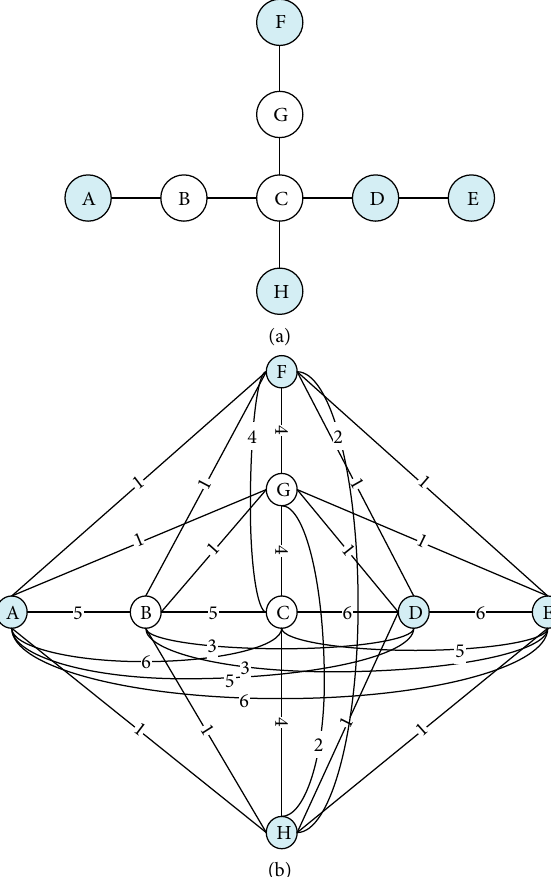
Figure 2: (a) Railway physical network (RPN) and (b) train flow network